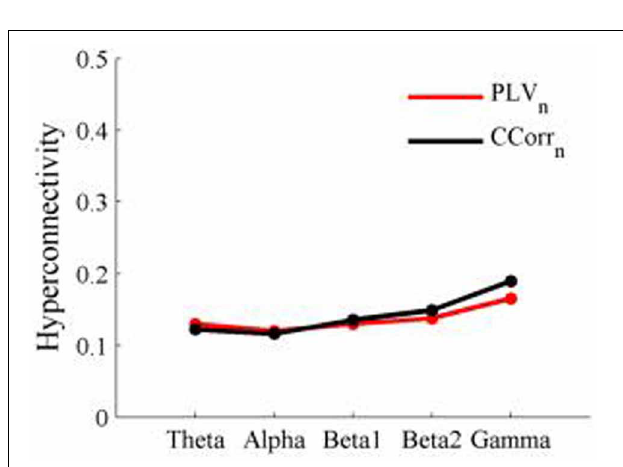
FIGURE 11 | Mean Hyperconnectivity values for trial-averaged event-related EEG by connectivity measure and frequency